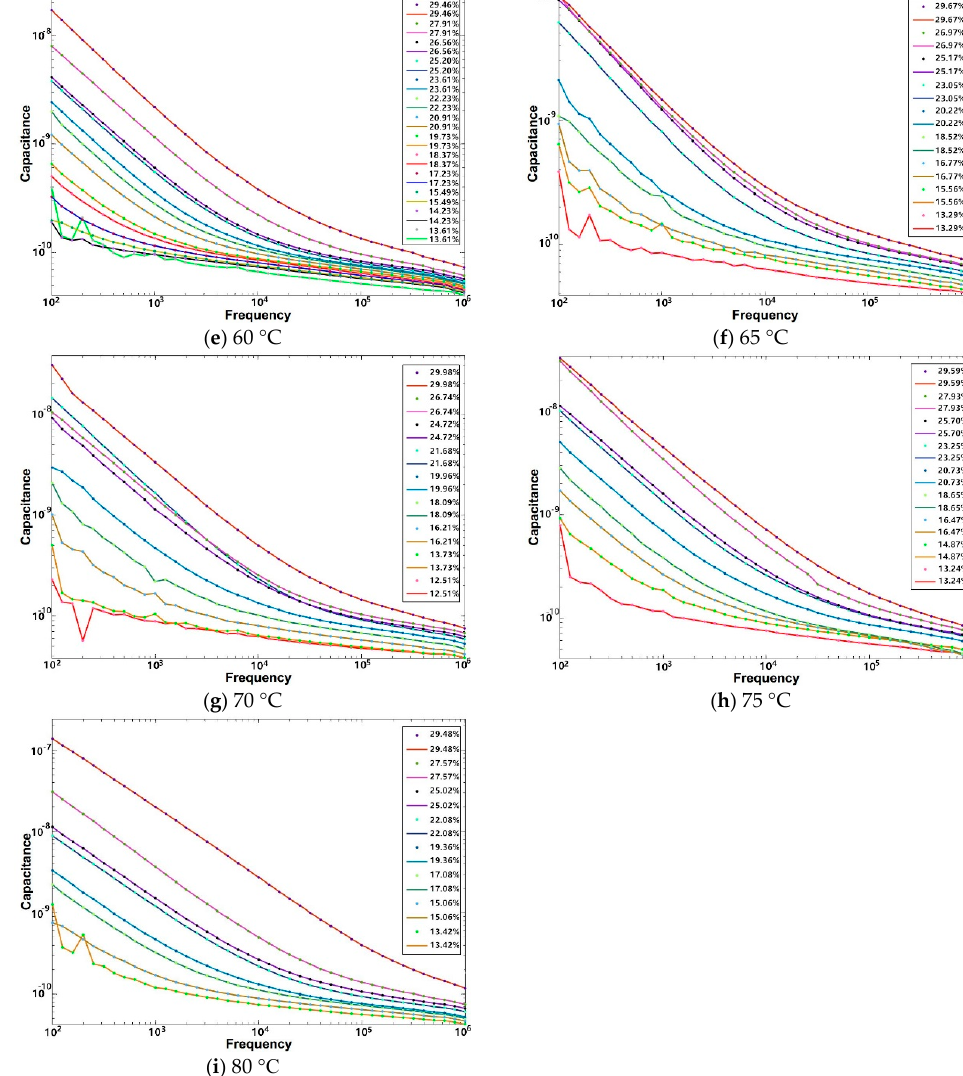
Figure 2. Frequency dependence of capacitance at temperature ranges of 40 to 80 °C.